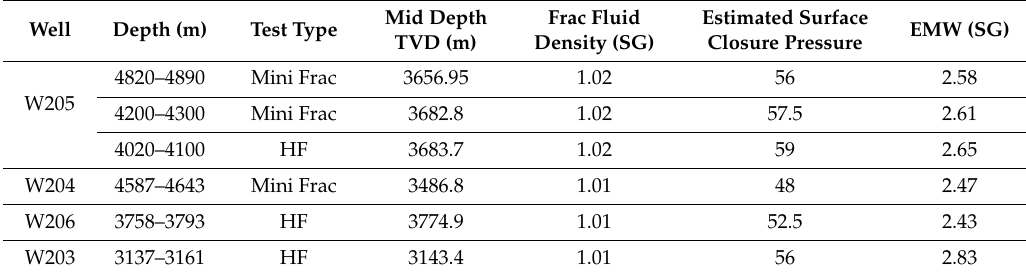
Table 5. Mini fracture and hydraulic fracturing data.